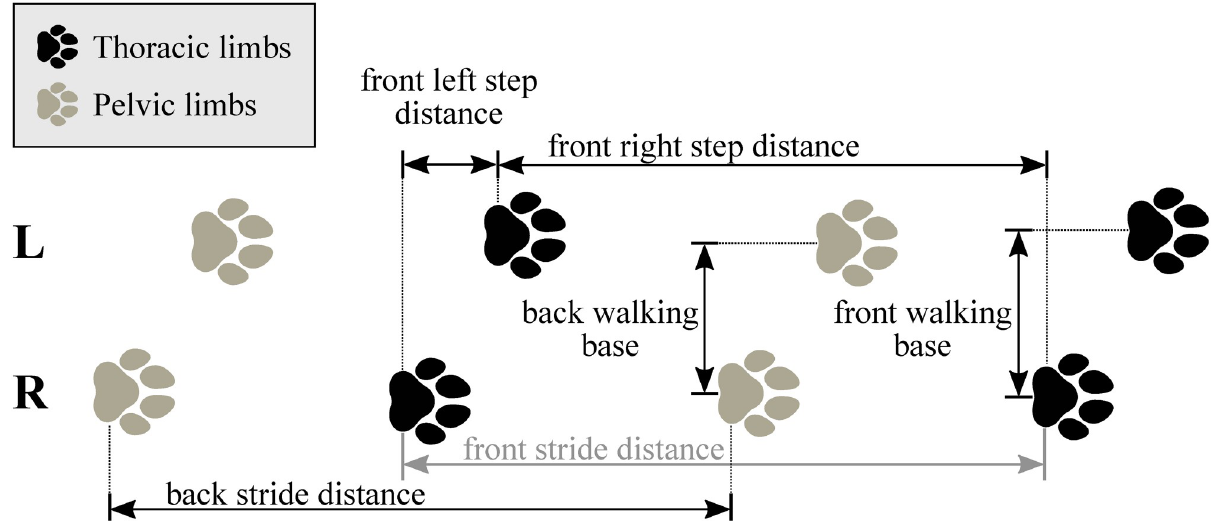
Fig 7. Distance type parameters in the horizontal